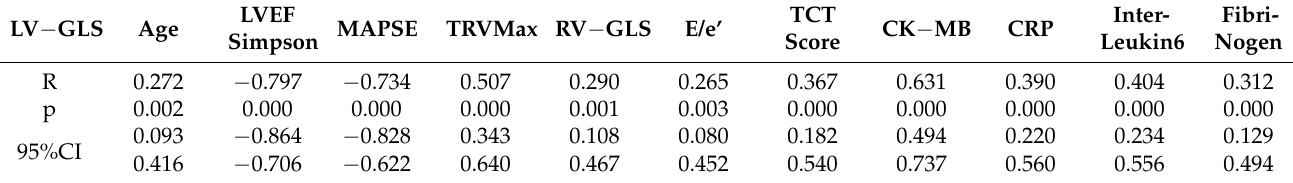
Table 4. Correlations between left ventricular global longitudinal strain (LV-GLS), other TTE parameters, and laboratory data in patients with diastolic dysfunction (DD) coinciding or not with altered left ventricular systolic function